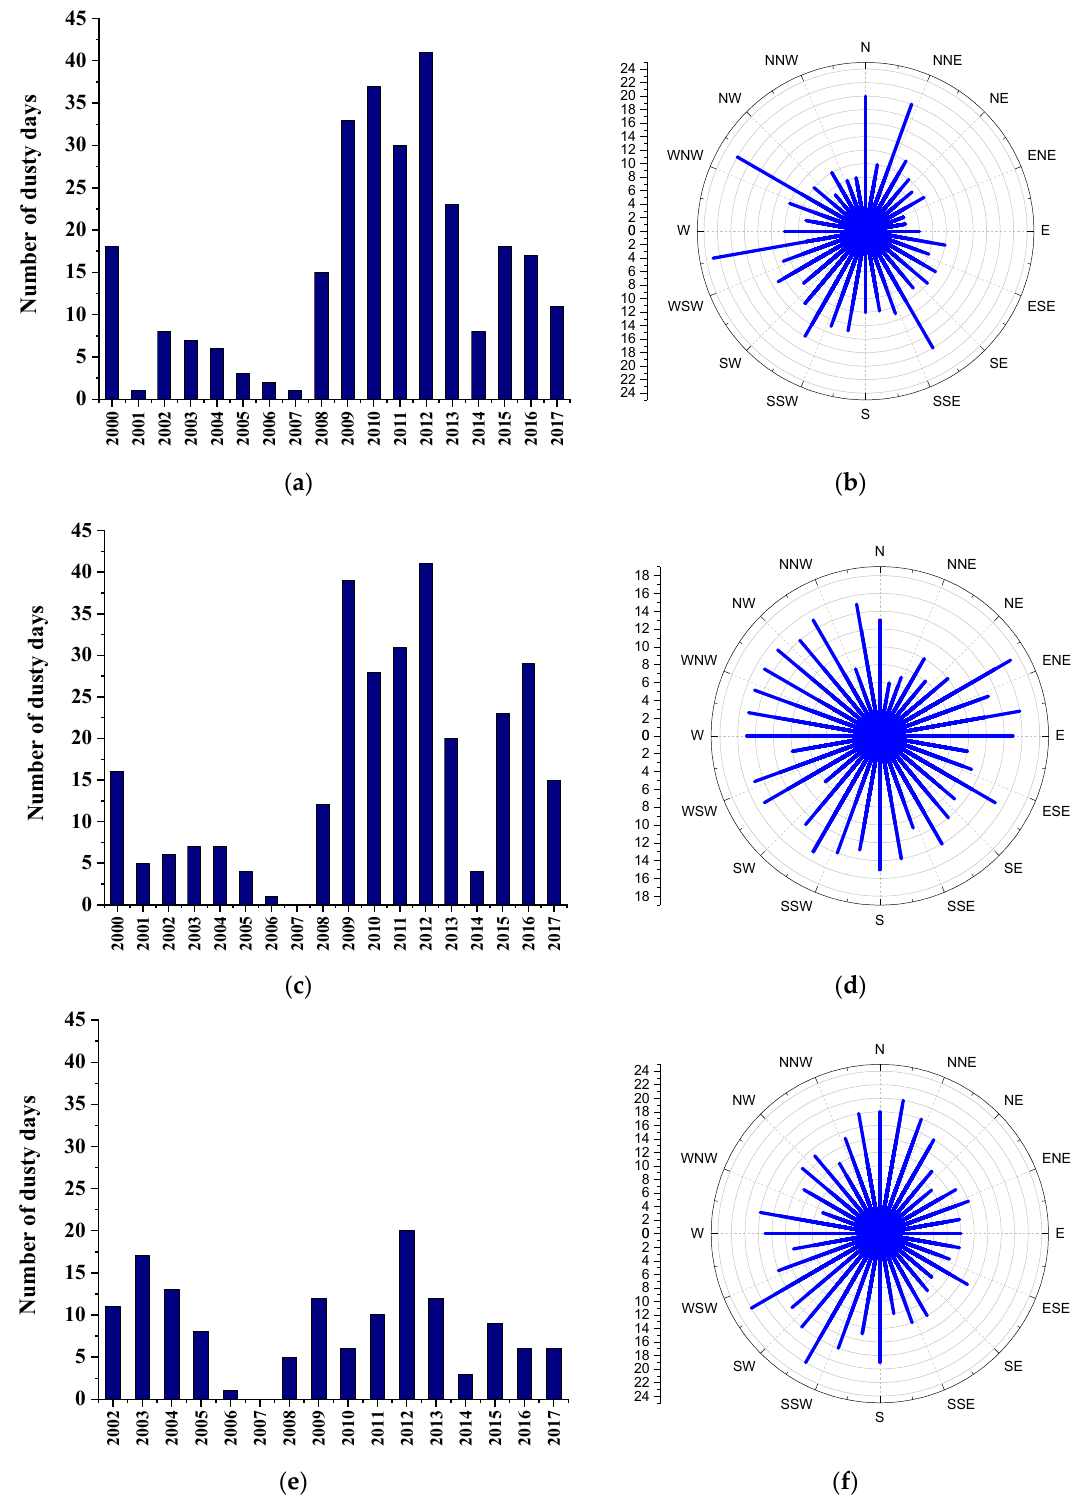
Figure 3. The number of dusty days and wind rose in dusty days in weather stations of Urmia ( a , b ), Bonab ( c , d ), and Salmas ( e , f ) in 18 years from 2000 to 2017. In contrast to the Urmia station, the wind primarily blows from Lake Urmia to the Tabriz station, with the prevailing wind being easterly and northeasterly. Another study [71] found that the wind rose in Bonab station (northeast of the lake) was eastly and north- easterly from 2012 to 2013. The data relating to the Salmas weather station from 2000 to 2017 show that the number of dusty days reached a peak in 2012, 2003, and 2009, with 41, 17, and 13 dusty days, respectively. The station’s prevailing winds were westerly, south- westerly, and north-westerly, and it was rarely affected by Lake Urmia’s saline dust storms, so the annual number of dusty days was much lower than that of the Urmia and Bonab stations. Figure 4 shows the dominant wind direction on dusty days at four weather stations around Lake Urmia from 2000 to 2017. The wind direction was primarily northerly and southerly in the Urmia and Salmas weather stations on the western side of the lake, but southwesterly in the Tabriz and Bonab stations on the eastern side. Furthermore, the mean wind speed on dusty days over 18 years was 6.2 m/s in the Salmas station, which was higher than the other three stations. The mean wind speed in Tabriz, Urmia, and Bonab weather stations were 5.6 m/s, 4.9 m/s, and 3.4 m/s, respectively.